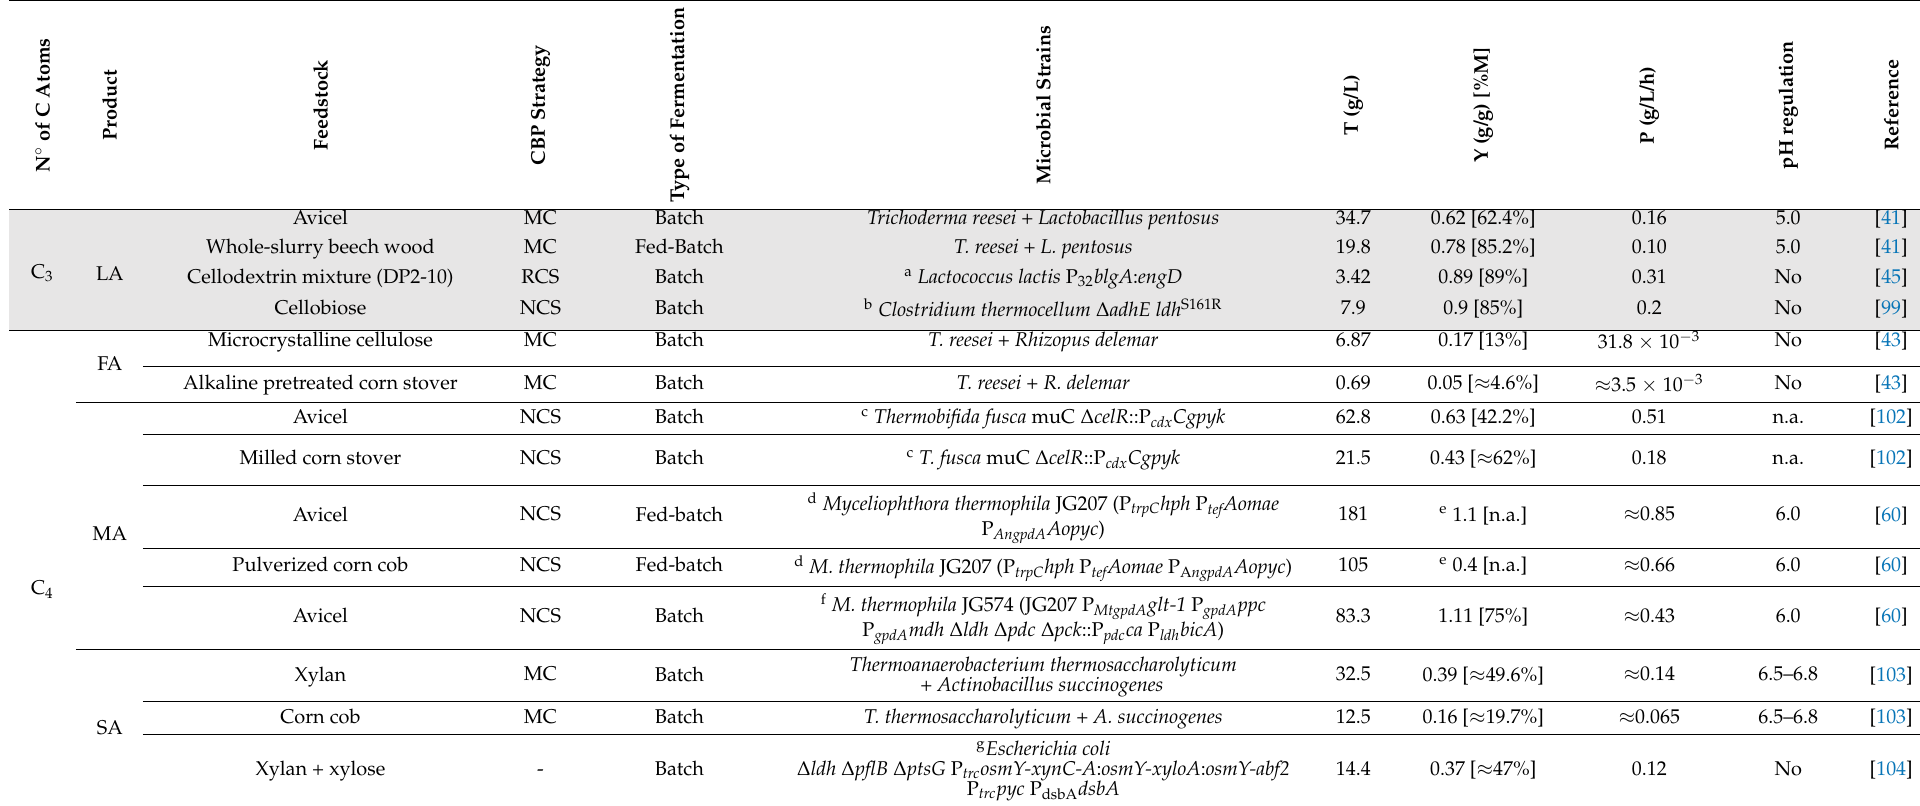
Table 2. Most successful examples of CBP of lignocellulosic biomass to organic acids. Maximum theoretical yields were calculated as follows: lactic acid, 2 mol/mol glucose (i.e., Embden-Meyerhof-Parnas pathway followed by pyruvate reduction by lactate dehydrogenase); fumaric, malic, succinic acid, 2 mol/mol glucose (i.e., reductive TCA pathway); itaconic acid, 1 mol/mol glucose (i.e., TCA cycle); adipic acid, 0.92 mol/mol glucose (reverse adipate degradation pathway); cis , cis -muconic acid, 1 mol/mol monoaromatic hydrocarbon (i.e., β -ketoadipate pathway); glucaric acid, 1 mol/mol glucose (i.e., synthetic pathway, see text). Maximum theoretical yields from pentose sugars were calculated based on phosphoketolase pathway and correspond to 1 mole of organic (fumaric, itaconic, lactic, malic, or succinic) acid per mole of sugar. The symbol “ ≈ ” was used for approximate values that were calculated from data in the corresponding studies. %M, % of theoretical maximum yield; AA, adipic acid; CBP, consolidated bioprocessing; CCM, cis , cis -muconic acid; FA, fumaric acid; GA, glucaric acid; IA, itaconic acid; LA, lactic acid; MA, malic acid; MC, microbial consortium; n.a., data not available; NCS, native cellulolytic strategy; P, volumetric productivity; RCS, recombinant cellulolytic strategy; SA, succinic acid; T, titer; Y, yield.